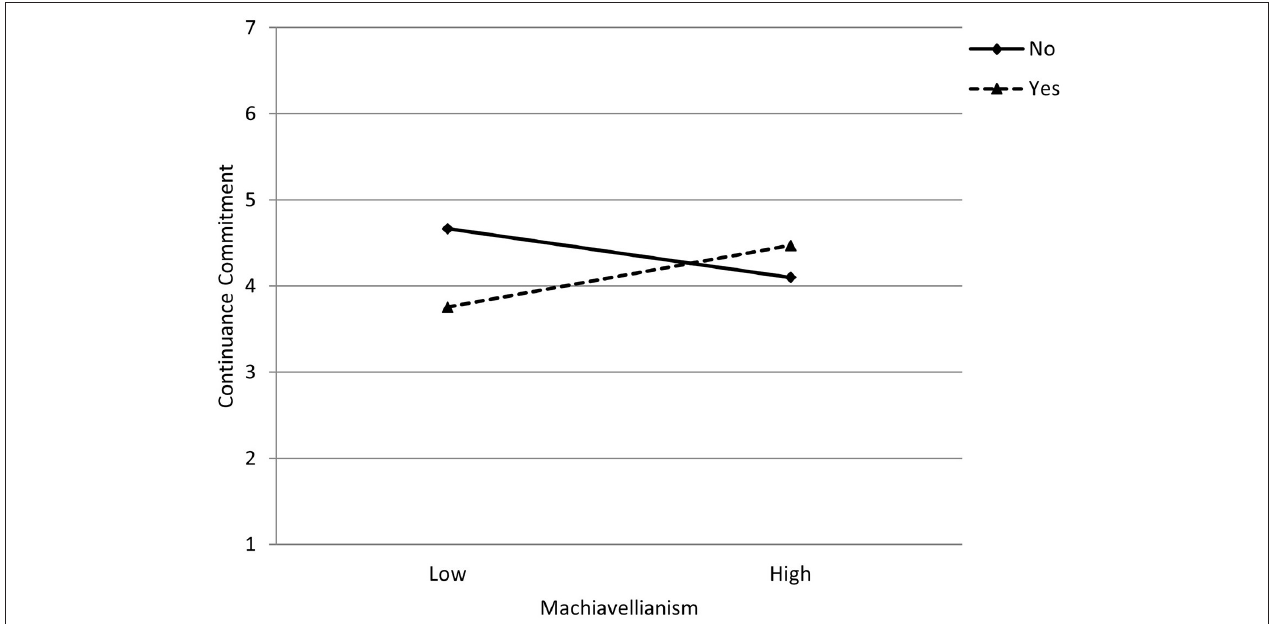
FIGURE 3 | Interaction between Machiavellianism and career interruption in their impact on continuance commitment. Lines represent whether the participant did or did not report a significant career interruption.